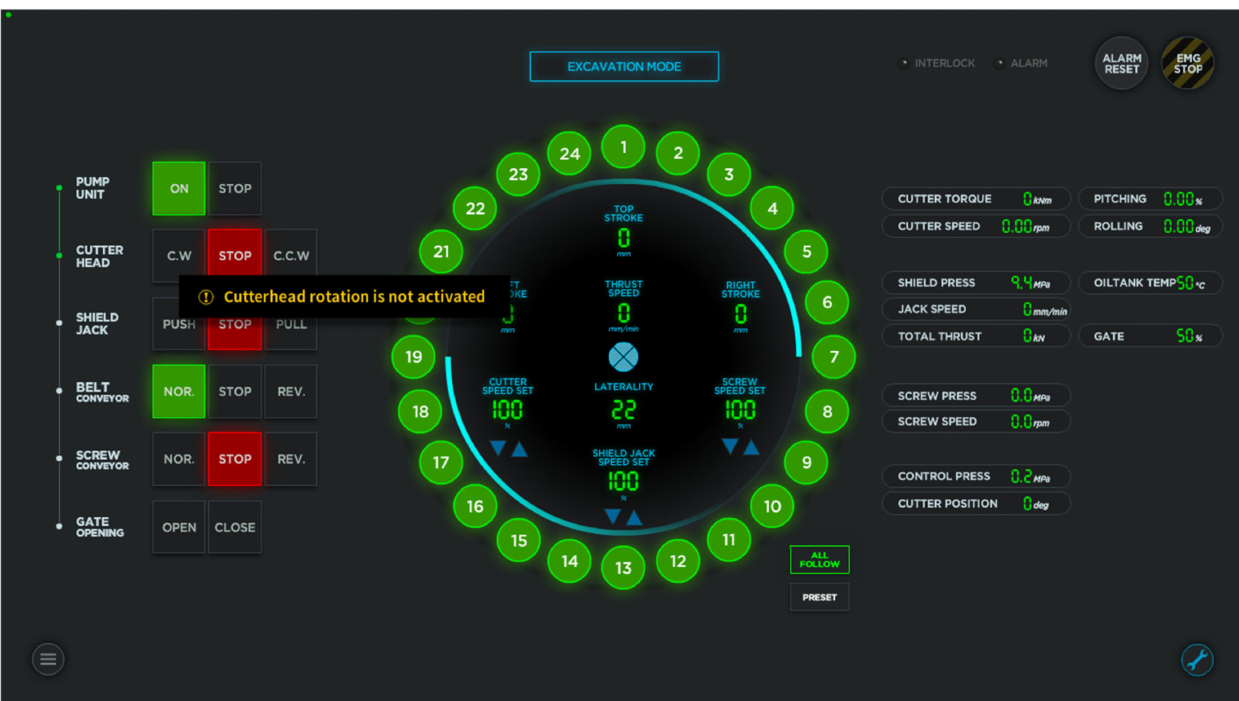
Figure 5. Example of mandatory interlock system associated with shield jack operation. The elective interlock system is closely related to the warning system, which can be divided into seven types depending on the TBM parts (Table 6). The warning system can be activated according to the state of the elective interlock system. If the elective interlock associated with the shield jack pressure is turned on, only the warning system for that jack can be activated. Warning system includes two main stages: displaying a warning message and sounding an alarm. Threshold values are pre-set for each stage: first messages are displayed, then the alarm rings if the situation worsens. The warning system have two stages: warning and error . Messages for both stages are displayed on-screen depending on the seriousness. The warning threshold is 20% less than the error threshold. For example, if the thrust reaches 80% of the maximum capacity (a pre-set value), a “THRUST WARNING” message is displayed. If the thrust then reaches 100%, a “THRUST ERROR” message replaces the warning message. The operator can resolve the warning issue as shown in Figure 6. If a warning signal is displayed, the operator should identify its cause and adjust the appropriate operational action. If there are not any solutions for the warning, operator should press the emergency button. If the operator can solve the problem, the operator should adjust the appropriate operational actions following the warning cause. However, if the problem cannot be solved and the situation worsens with an error signal display, the operator should press the emergency button to stop the entire excavation. If the operator does not press the button within a set time, the interlocked emergency shutdown system automatically suspends the entire